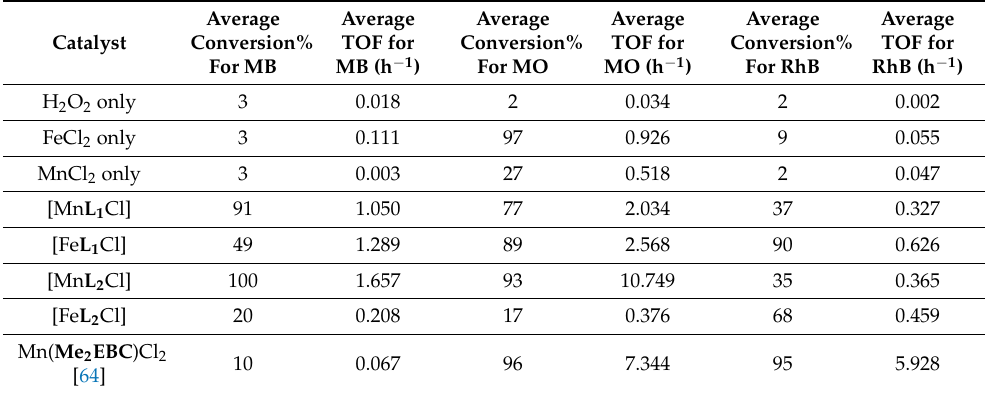
Table 4. Turnover Frequency (TOF) values for control and all four metal-complex catalysts for Figure 5 . Plot of A t /A 0 vs. time for decolorization of 3 dyes (MB, MO, and RhB) using( a ) [Mn L 1 Cl] degradation of MB, MO, and RhB at pH = 7. and ( b ) [Fe L 1 Cl] as catalysts. [Note: The time = 0 initial points for all three dyes are congruent, as the time = 0 point is defined as 1.0 in the ratio A t /A 0 for all three dyes. Individual plots of each dye are available in the supplementary information.].